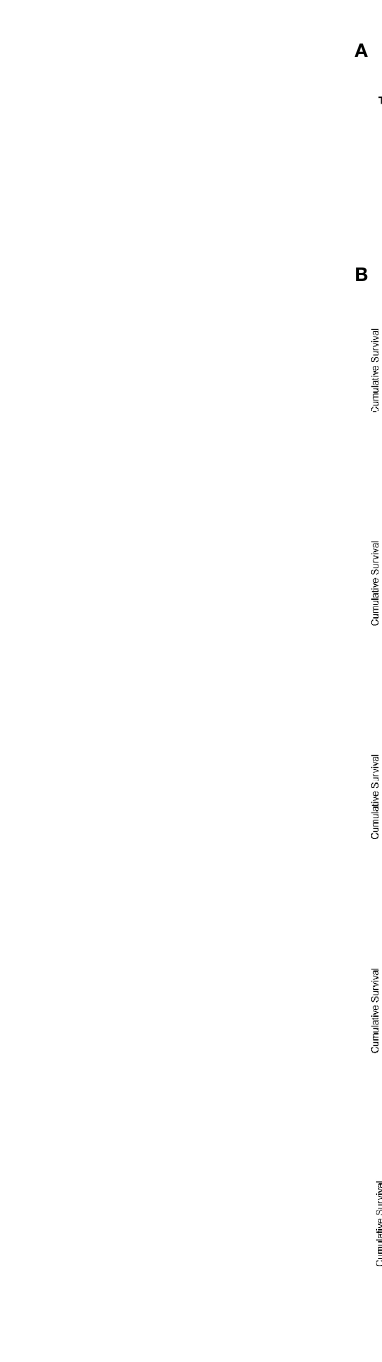
FIGURE 1 | Prognosis-correlated data of CD8+ T cells from patients with HPV − and HPV+ HNSCC. (A) A heat map of data from the multiple-variate Cox proportional risk model in terms of CD8+ T cells from patients with HPV − versus HPV+ HNSCC. The z-scores represent the risk scores. (B) Kaplan-Meier survival analysis showing the levels of CD8+ T cells from patients with HPV − (right column) and HPV+ (left column) HNSCC by using MCPcounter, CIBERSORT, CIBERSORT-ABS, XCELL and QUANTISEQ